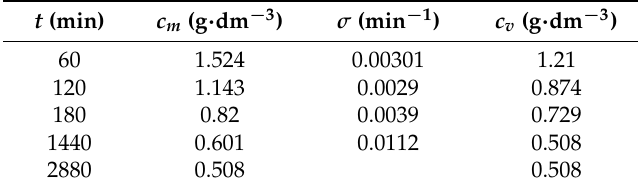
Table 6. Temporal change of cupric cations and calculated